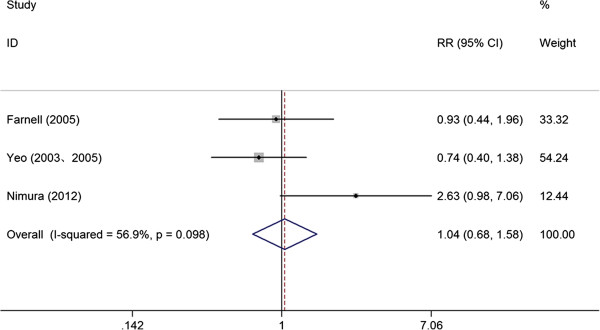
Forest plot for the 5-year survival rate between the pancreatoduodenectomy with extended lymphadenectomy (PD/ELND) group and the standard pancreatoduodenectomy (PD) group. The size of the black box corresponding to each study is proportional to the sample size, and the horizontal line shows the corresponding 95% CI of the relative risk (RR) displayed on the right.